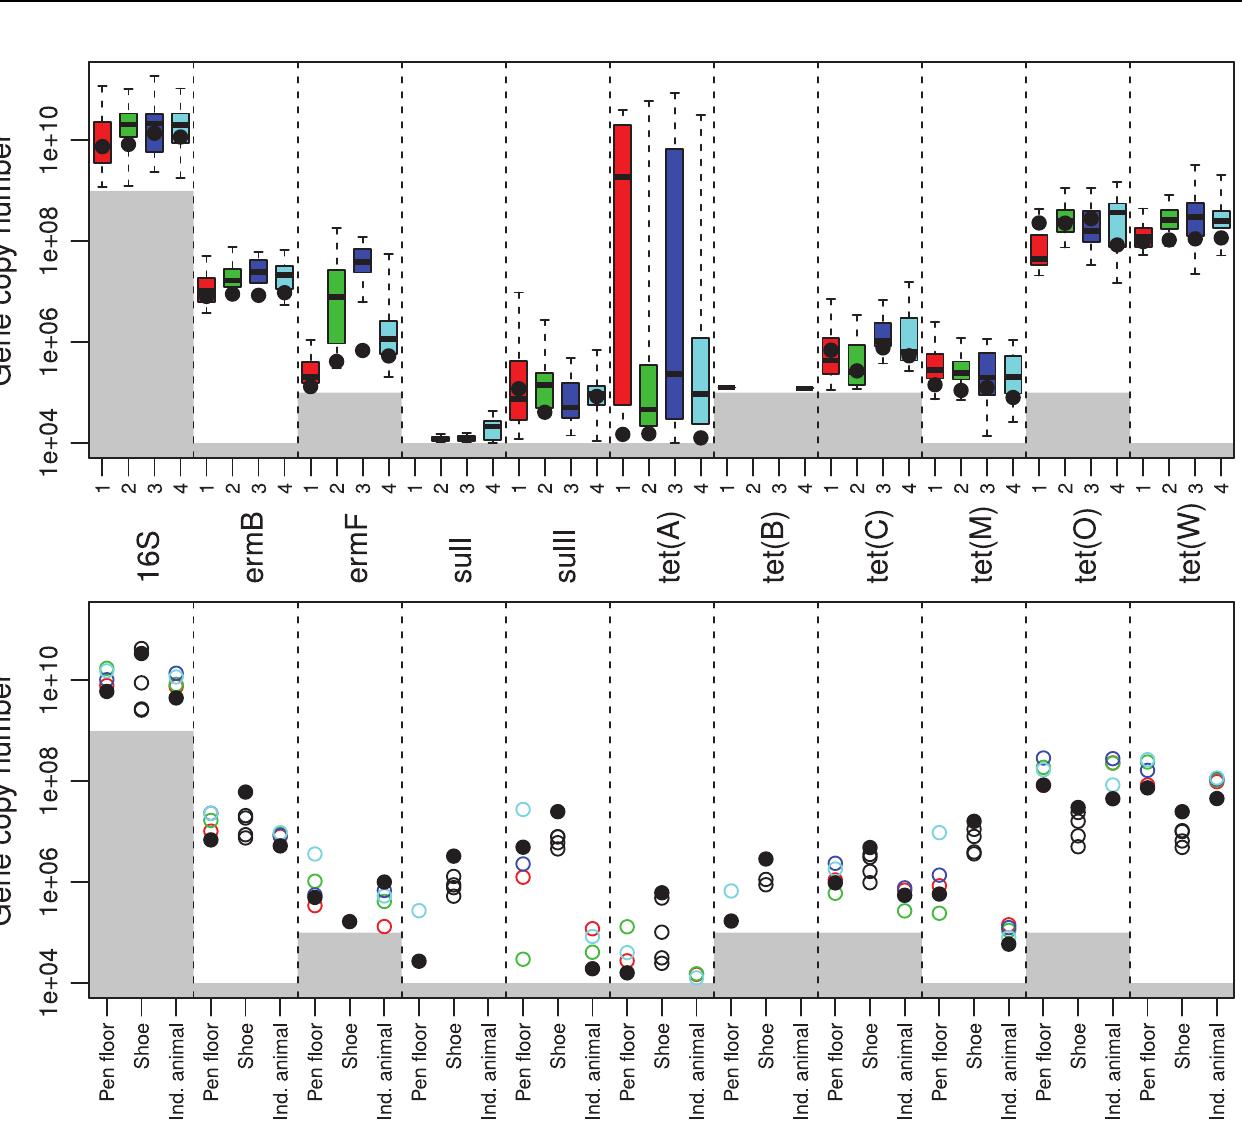
Fig 2. Sampling 1 gene copy numbers g -1 feces in individual animals within pens 1 – 4. Top: Boxplot showing the distribution of gene copies above the limit of quantification, LOQ (grey area = below LOQ) for individual animals within pens 1 – 4 from sampling 1 (pen 1, red, n = 22; pen 2, green, n = 20; pen 3, purple, n = 22; pen 4, blue, n = 20). The bottom and top of the boxes are the first and third quartiles, respectively. The black band inside the box is the median and the “ dotted-whiskers ” represent the maximum (greatest gene copy number values, excluding outliers) and minimum (least gene copy number value, excluding outliers). The solid circles are the individual animal pool pen samples within each pen. Each column represents a denoted gene (the respective genes are depicted in the middle of the figure and are shared for the top and bottom section of Fig 2). Bottom: The distribution of gene copies above the LOQ (grey area = below LOQ) for different sampling and pooling methods from sampling 1. The sampling methods are given under the bottom figure (Pen floor = pen floor sample; Shoe = shoe cover sample; Ind. animal = Individual animal sample). Each pen is represented by their colored circle for the pen floor and Ind. animal samples (pen 1, red circle; pen 2, green circle; pen 3, purple circle; pen 4, blue circle). The shoe cover samples are the same 4 shoe covers that were used in all 4 pens (individual shoe cover samples are empty black circles). The stable pools of the respective sampling method, pen floor, shoe cover, Ind. animal, are solid black